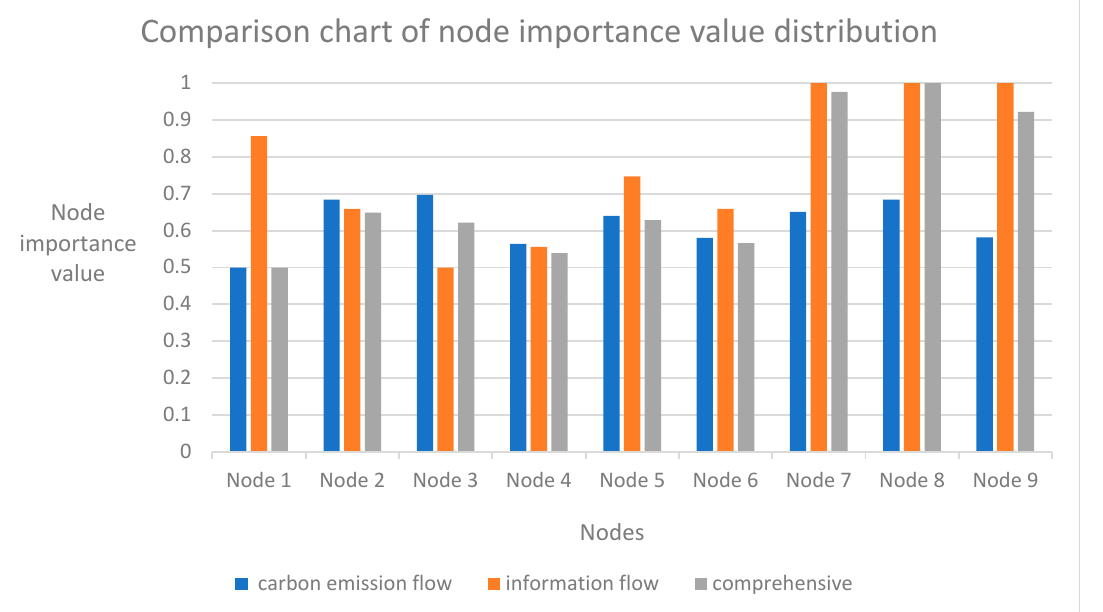
Figure 6. Comparison chart of node importance value distribution.